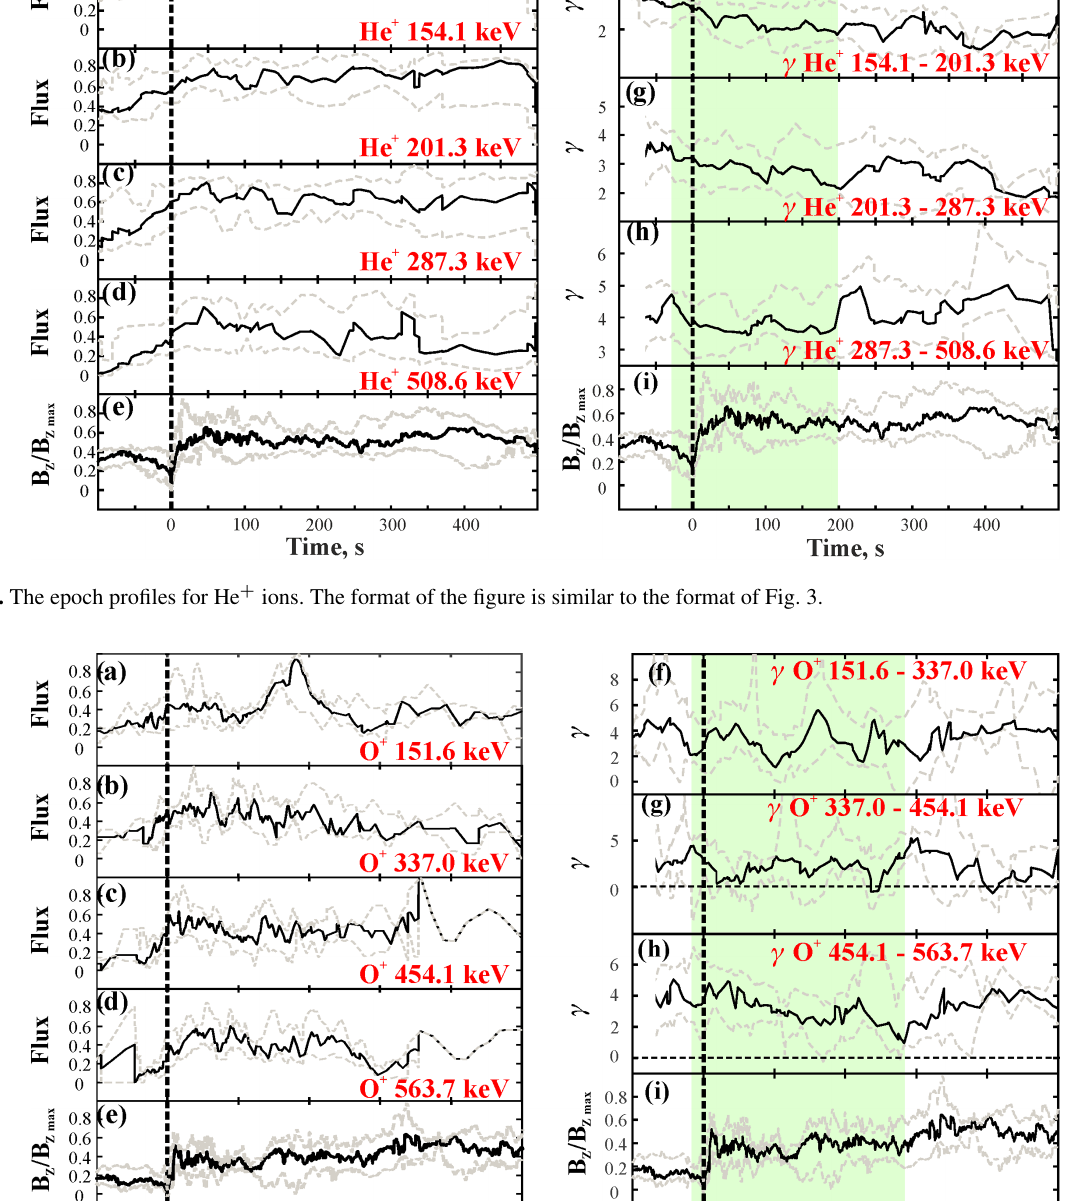
magnetic ramp thickness ( l f ) and DF width ( L f ). It was also shown that the acceleration of charged particles also depends on the initial energy and mass of ions (Greco et al.,